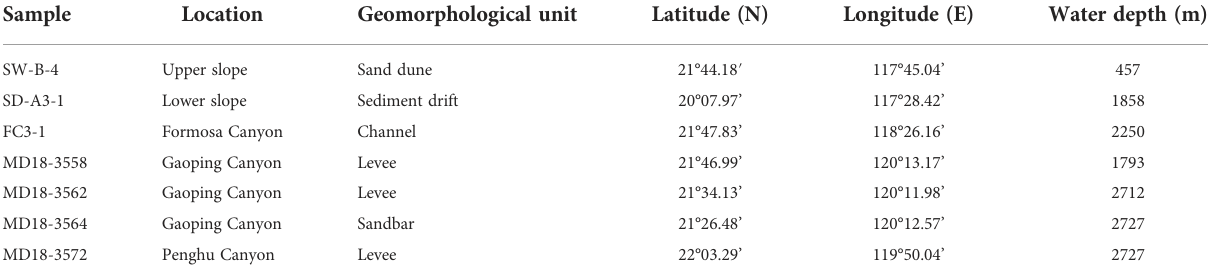
TABLE 1 Locations of deep-sea surface sediments for the microplastic study in the northern South China Sea.